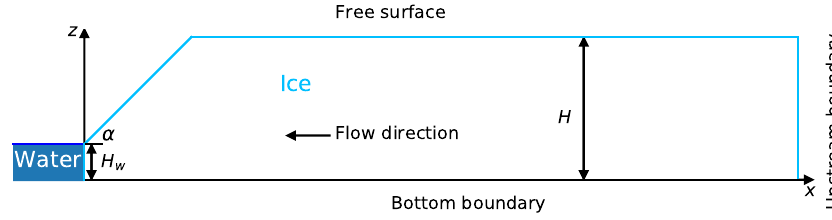
Figure 2. Geometry of the idealized grounded glacier. α is the slope angle of the calving front above the vertical cliff.